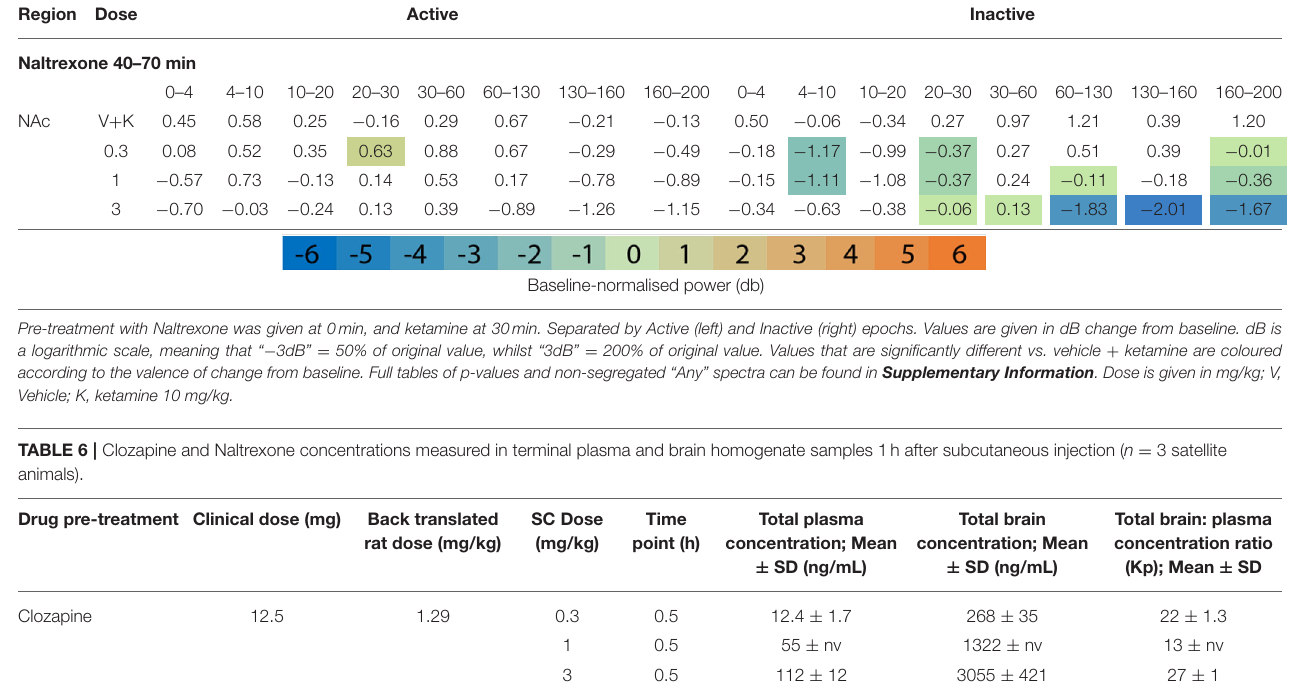
TABLE 5 | Table of averaged power spectra at 40–70min. Region Dose Active